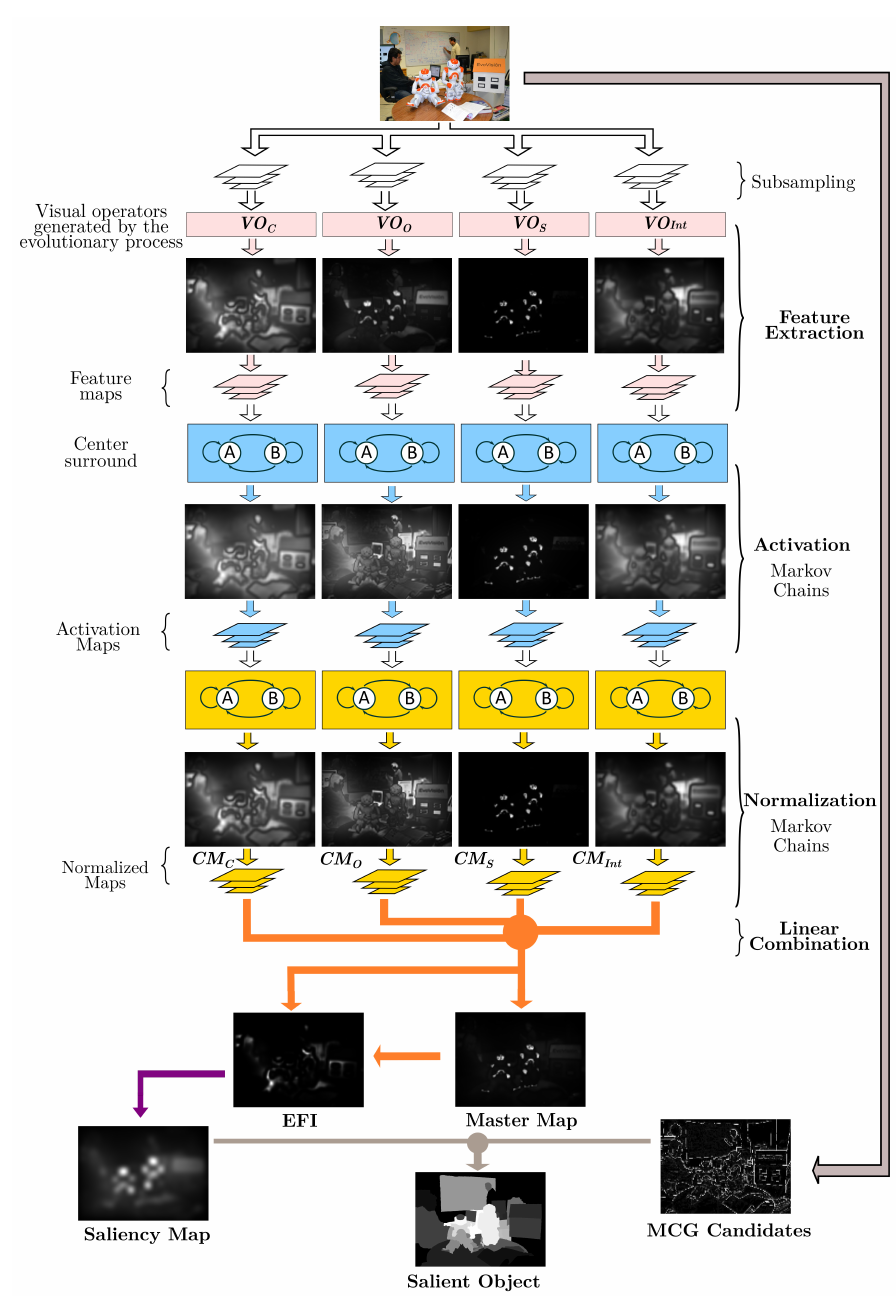
Figure 5. Brain programming result of the dorsal stream using the best GBVS + MCG